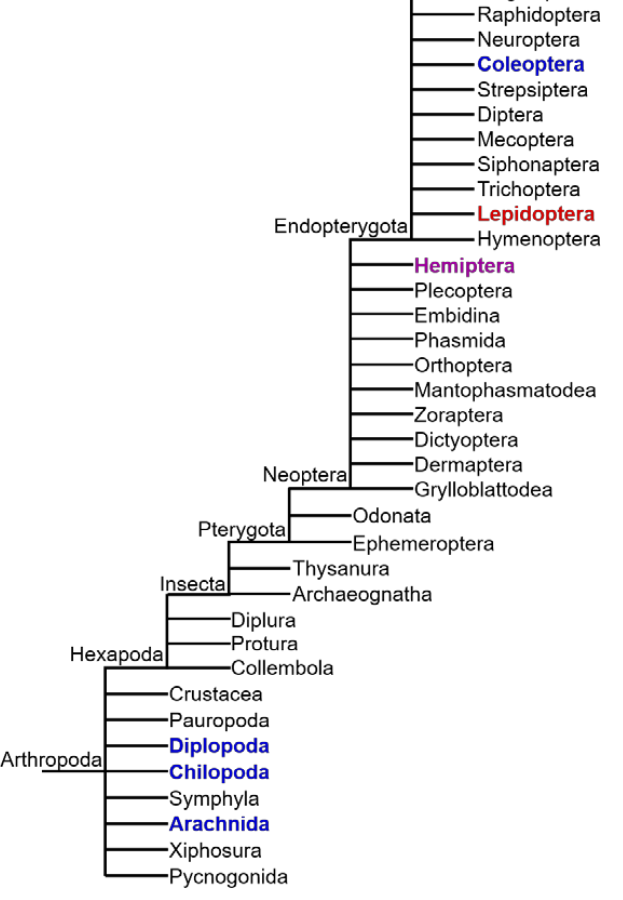
Figure 6. Schematic representation of Arthropod phylogeny with clades containing species carrying aliphatic ( red ) and aromatic ( blue ) CNglcs, as well as other cyanogenic compounds ( purple ). Cyclopentenoid CNglcs are only found within Heliconiinae butterflies (Lepidoptera). Based on Tree of Life web project (http://tolweb.org). Only extant clades are included.